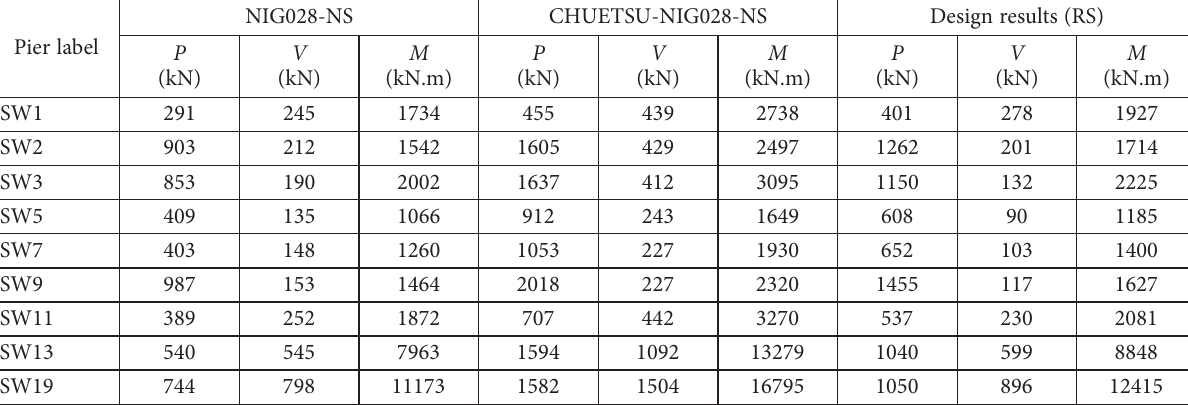
Table 1. Maximum inelastic response quantities for shear walls and cores under Niigata ground motion inputs in the NS direction